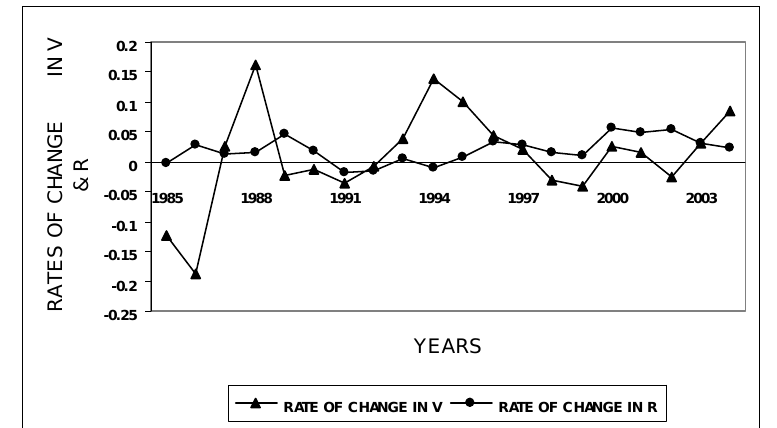
FIGURE 1: Investor Uncertainty and